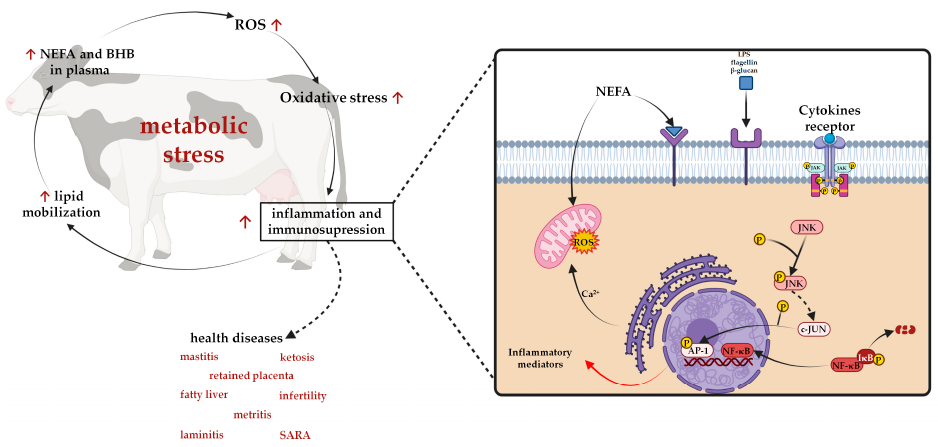
Figure 8. Schematic representation of the main factors affecting the health status of dairy cattle. Different stressors influence the inflammatory responses. Several factors such as non-esterified fatty acids (NEFAs) and β -hydroxybutyrate (BHB) can increase their concentration in plasma, increasing reactive oxygen species (ROS) production and activating pattern recognition receptors (PRRs). In the same way, these receptors could be activated by interactions of endogenous factors such as lipopolysaccharides (LPS), flagellin or β -glucans. Cytokine receptors and certain G-protein receptors also could be activated by different inflammatory mediators. The stimulation of these receptors leads to the activation of two different key transcription factors: activator protein 1 (AP1) and nuclear factor kappa (NF-KB) (light-chain-enhancer of activated B cells), which promote the expression of tumour necrosis factor alpha (TNF α ), IL-6, IL-1, IL-8, etc. In particular, the phosphorylation of c-Jun leads to translocation in the nucleus and dimerization with c -Fos, promoting training of AP-1 transcriptional factor. Instead, the phosphorylation of an inhibitor of kappa B (I κ B) leads to its degradation and to the activation of transcriptional factor NF-KB [117,118]. Figure created with